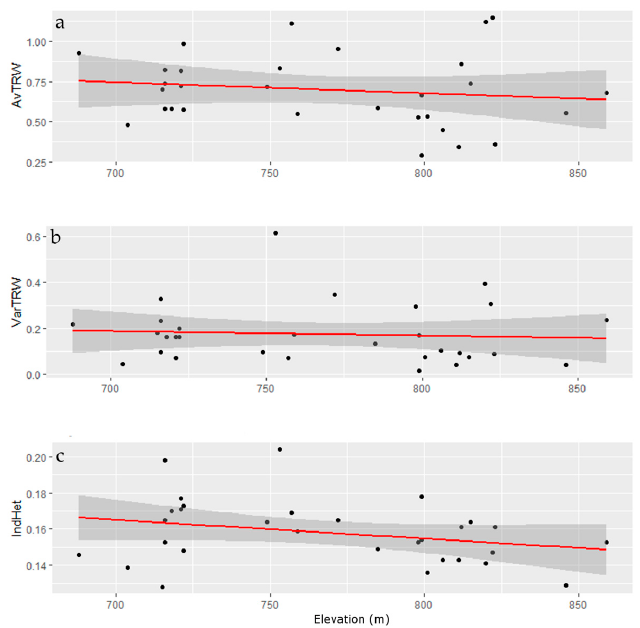
Figure 3. Regression analysis comparing the ( a ) average tree-ring width (AvTRW) ( adjR 2 = − 0.01398, intercept = 1.2204, slope = − 0.00068, p = 0.445); ( b ) tree-ring variance (VarTRW) ( adjR 2 = − 0.03036, intercept = 0.3214, slope = − 0.00019, p = 0.706) and ( c ) individual heterozygosity (IndHet) ( adjR 2 = 0.0460, intercept = 0.2373, slope = − 0.00010, p = 0.133) with elevation (m). No significant associations were found. Forests 2017 , 8 , 418